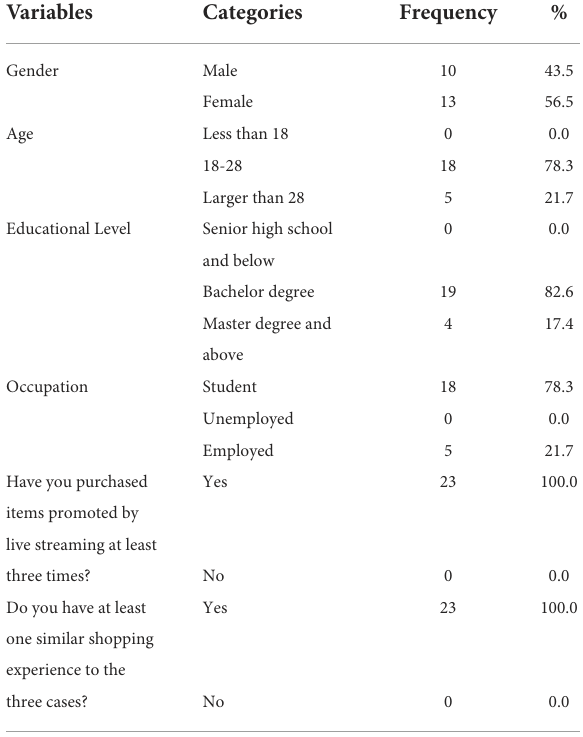
TABLE 1 The descriptive statistics of the informants ( N =